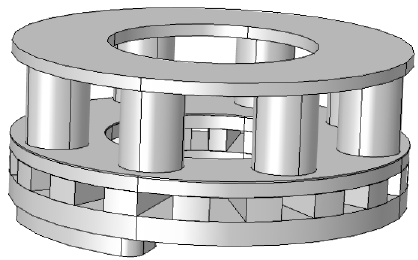
Figure 2. Three-dimensional model of the integrated brake.